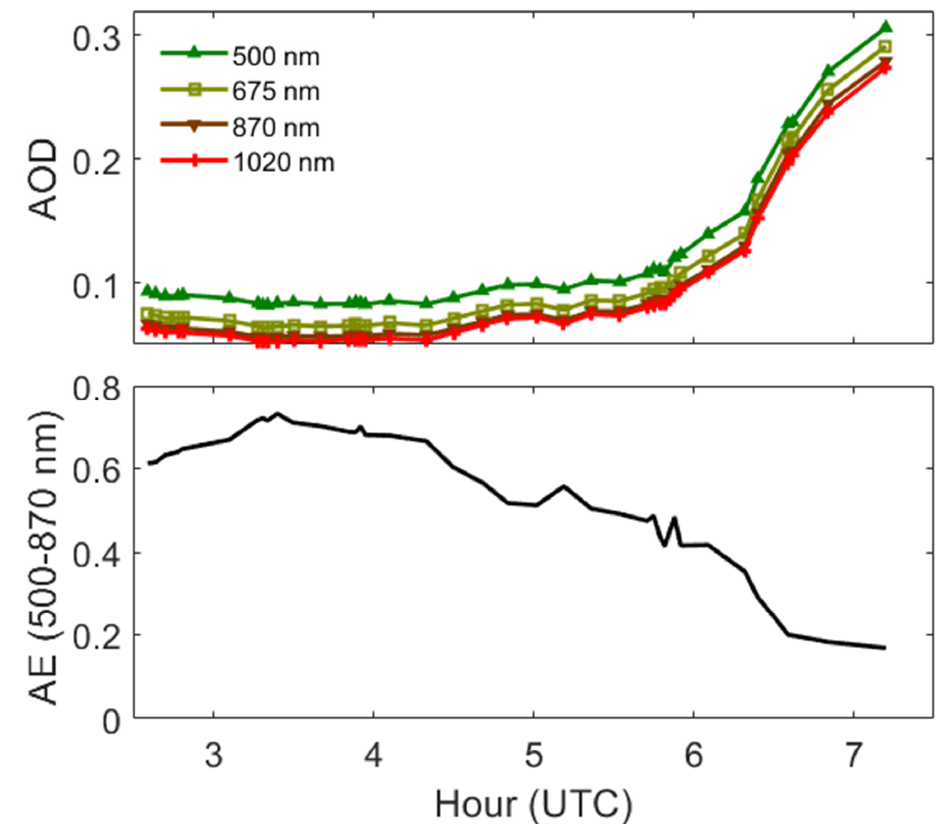
Figure 4. The aerosol optical depth (AOD) and Ångström Exponent (AE) measured on 22 June 2018 at the AERONET site at Kuwait University. Note the rapid increase (decrease) in the AOD (AE) between 6:00–9:00 UTC corresponding to the onset of the SDS at 9:00 a.m.–10:00 a.m. on Kuwait local time.